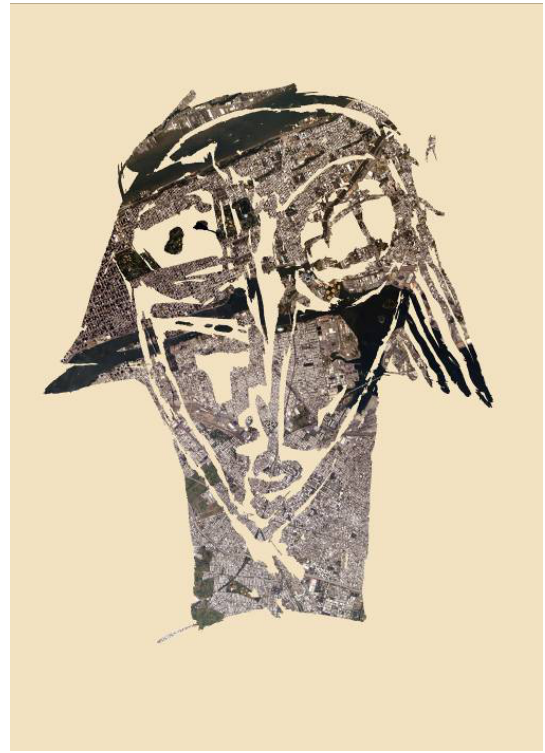
Figure 6 Tamer Assem – New York Woman – Digital Print – 70x50cm – (2017)